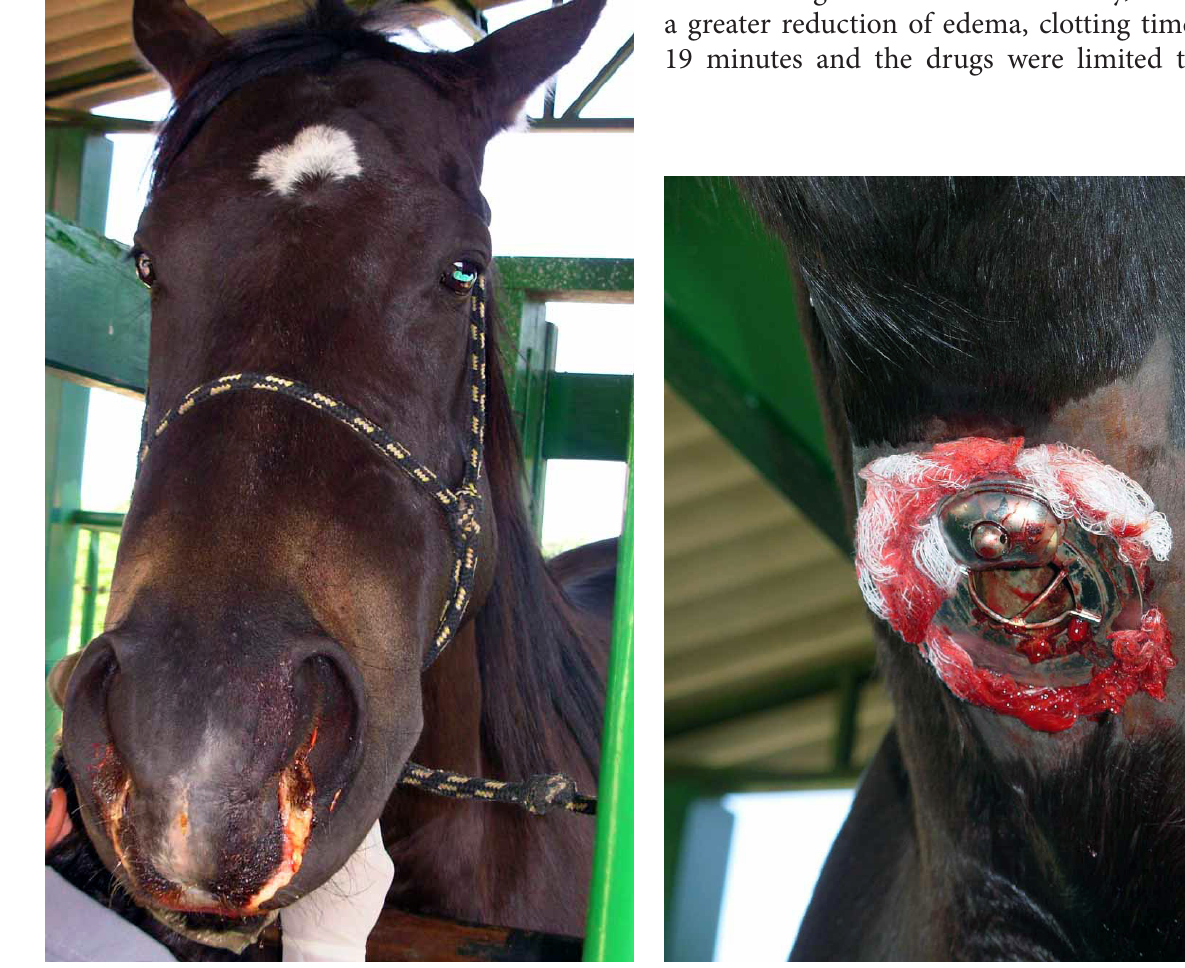
Figure 3 . Emergency tracheostomy due to the presence of acute respiratory